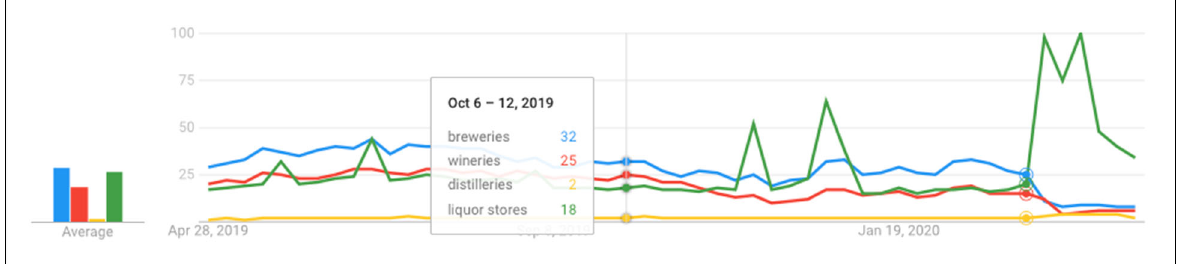
Source: Google Trends, April 27, 2020; the geography of search is the U.S.; circles to the right show week of March 8–14, 2020 as